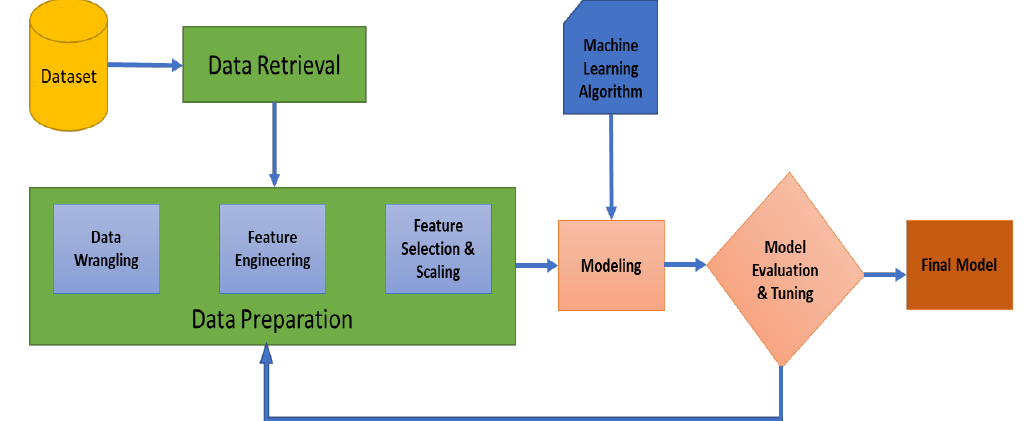
Figure 1. Schematic illustration of our proposed